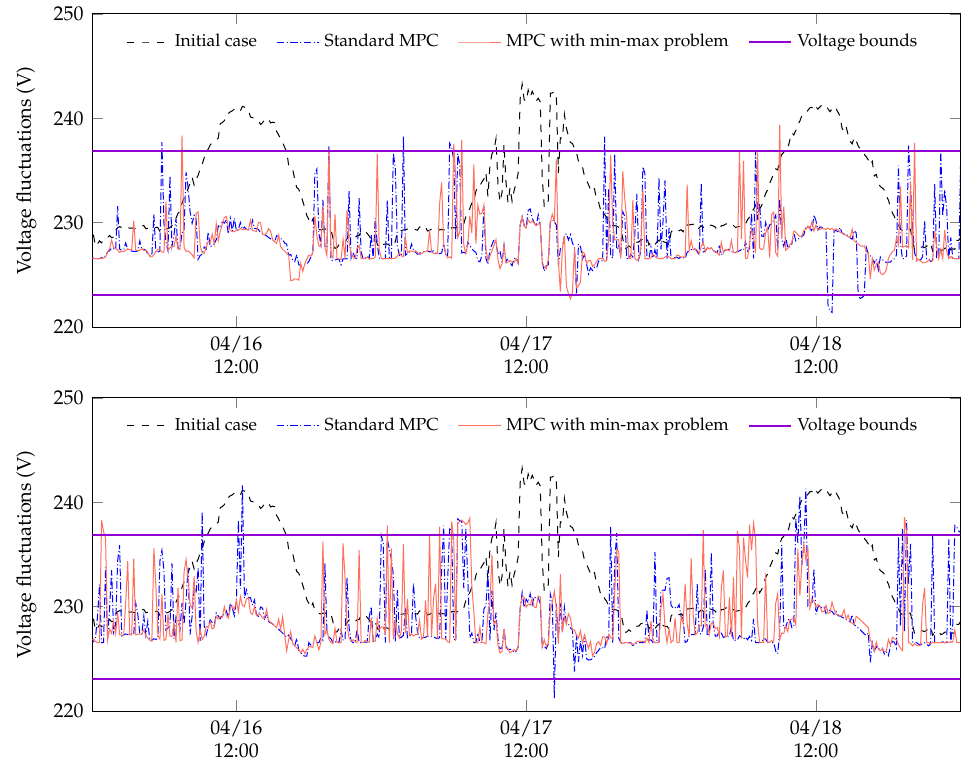
Figure 10. Extrema of voltage fluctuations within the power distribution grid for the standard MPC strategy compared to the one using a min–max problem and to the initial case, displayed for a 4 h sliding window ( top ) and a 10 h sliding window ( bottom